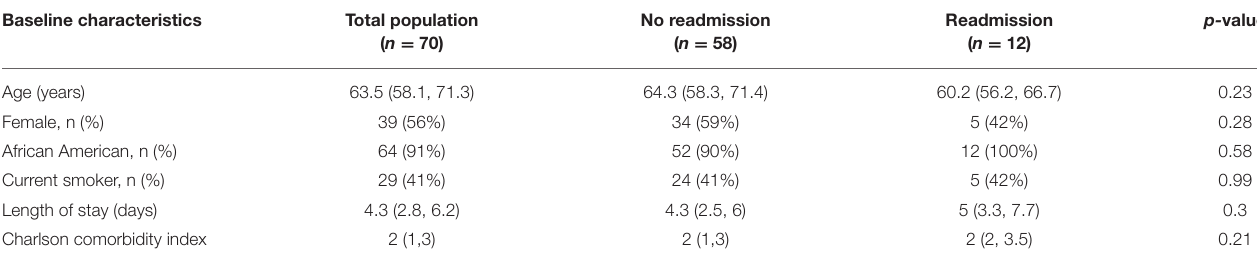
TABLE 1 | Baseline characteristics of total sample. Baseline characteristics